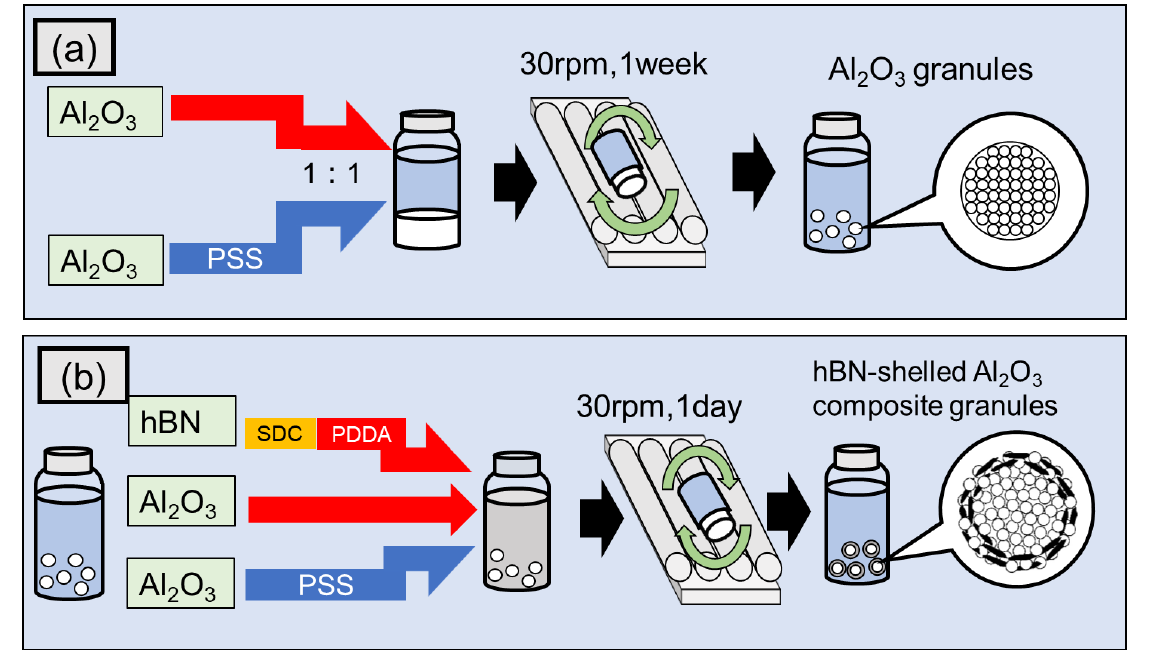
Figure 1. The fabrication schematic of the ( a ) Al 2 O 3 granules and ( b ) Al 2 O 3 –hBN core–shell composite granules using the electrostatic integrated granulation method.